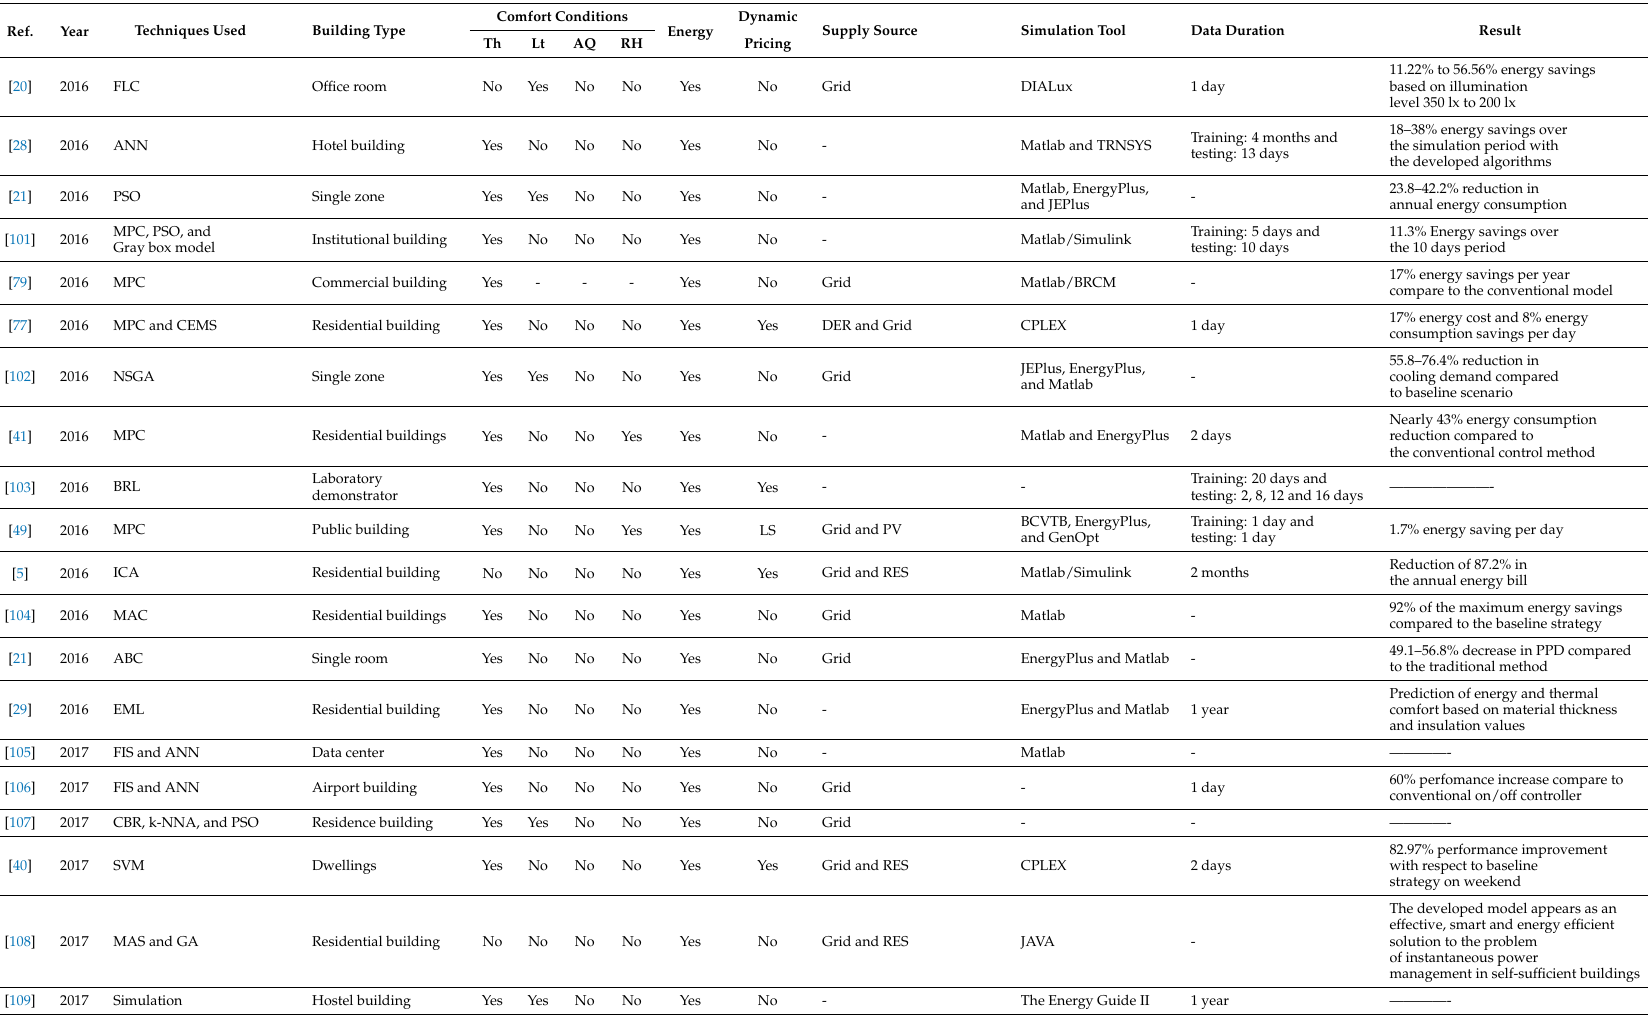
MatlabandTRNSYS Training: 4monthsand testing: 13days